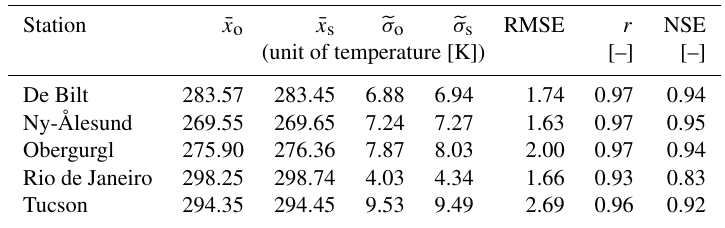
Table 3. Model performance measures for temperature disaggregation (T1b model). ¯ x o and ¯ x s are the mean values of observed and disaggre- gated temperature, respectively. The standard deviation of the observed ( e σ o ) and disaggregated ( e σ s ) time series are also specified. The root mean square error (RMSE), the correlation coefficient r , and the Nash–Sutcliffe model efficiency (NSE) are calculated using the observed and disaggregated time series for each station.